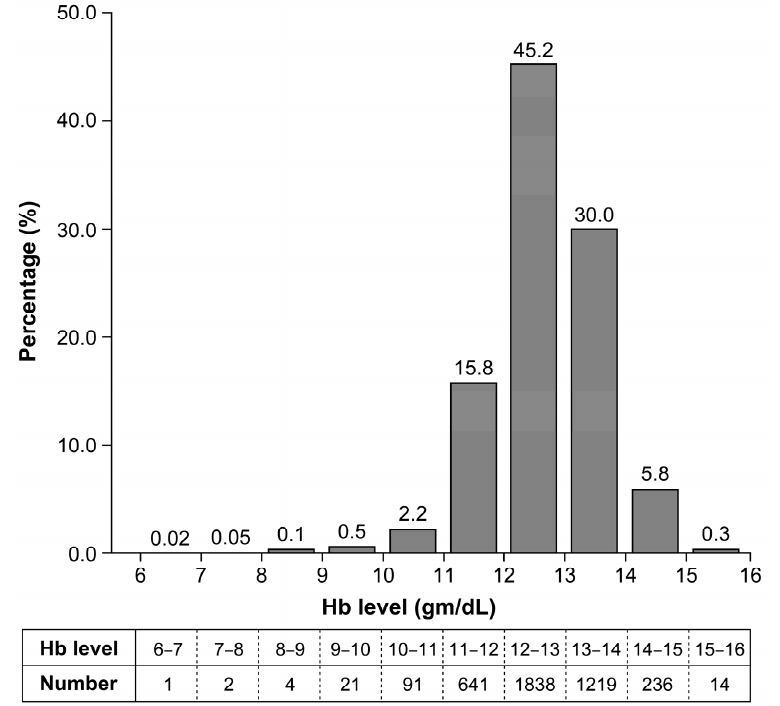
Figure 2. The distribution of hemoglobin level during the first trimester in Korean Pregnancy Outcome Study cohort.